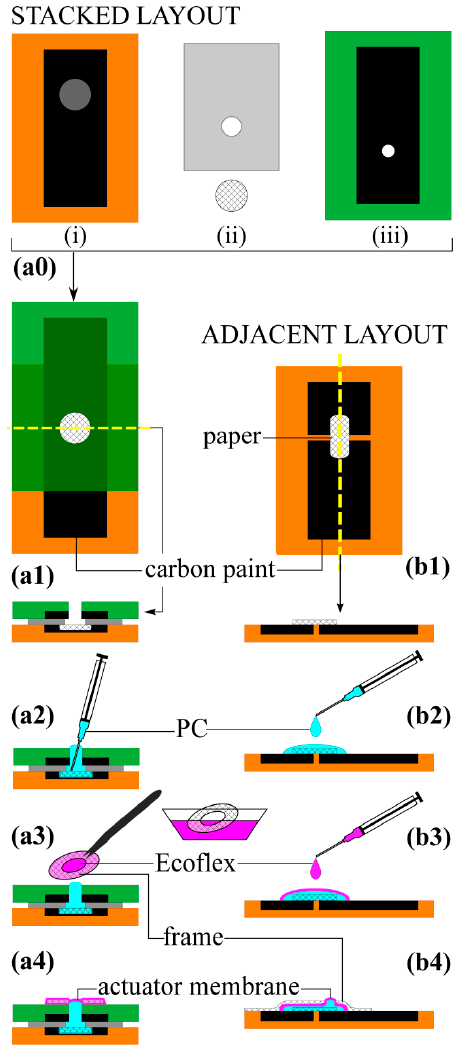
Figure 3. Fabrication process for actuators with stacked ( a0–a4 ) and adjacent ( b1–b4 ) electrodes. ( a0 ) The stacked layout began with preparing ( i ) a bottom electrode layer (orange) with a reservoir; ( ii ) an insulating layer (gray) and a paper disk; and ( iii ) a top electrode layer (green). The electrode layers were patterned by doctor-blading C-PDMS over a stencil, curing, and embedding in PDMS. Holes were punched in the upper two layers to form the fluid port. ( a1 , b1 ) Assembly. ( a1 ) The components of the stacked layout were plasma treated, aligned, and bonded. Overhead and cross-sectional views are shown; the section is indicated by the dashed line; ( b1 ) In the adjacent layout the electrodes were patterned using a cutting machine and embedded in PDMS. The paper was placed over the electrodes. ( a2 , b2 ) Addition of pumping liquid. ( a2 ) Liquid was added via the inlet hole; ( b2 ) Liquid was